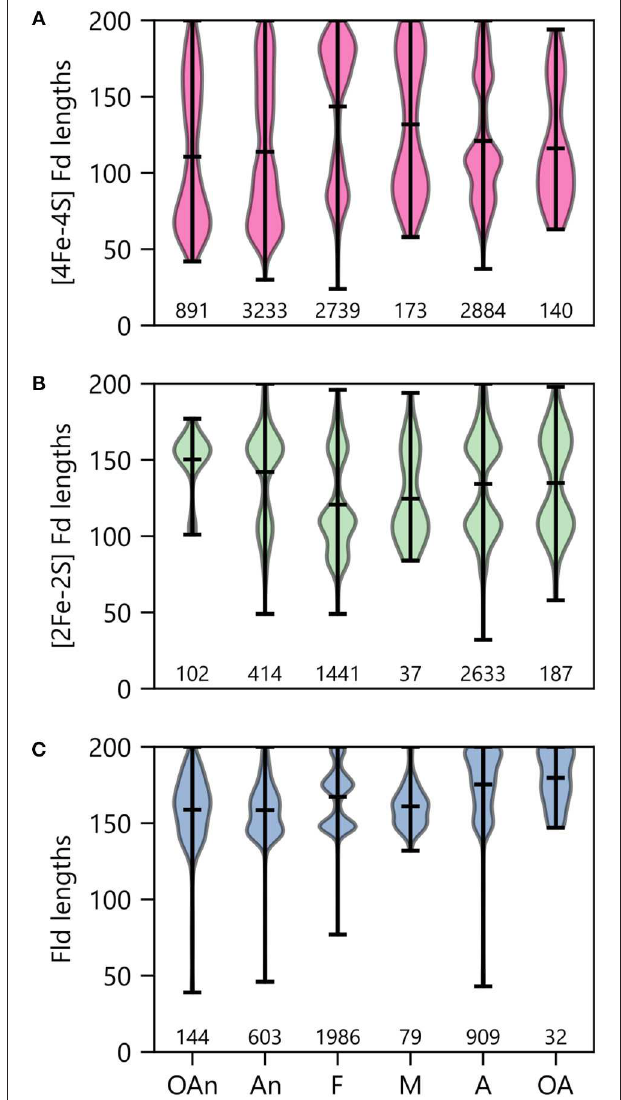
FIGURE 10 | PEC length distributions in organisms having different O 2 requirements. The lengths of (A) [4Fe-4S] Fd, (B) [2Fe-2S] Fd, and (C) Fld genes in organisms having distinct O 2 requirements. Growth requirements are abbreviated as obligate anaerobe (OAn), anaerobe (An), facultative (F), microaerophilic (M), aerobic (A), and obligate aerobic (OA). The extrema are marked by the horizontal bars at the edges of the vertical bars, and the average length is noted with an internal horizontal bar. The number of individual genes in each category is listed below each